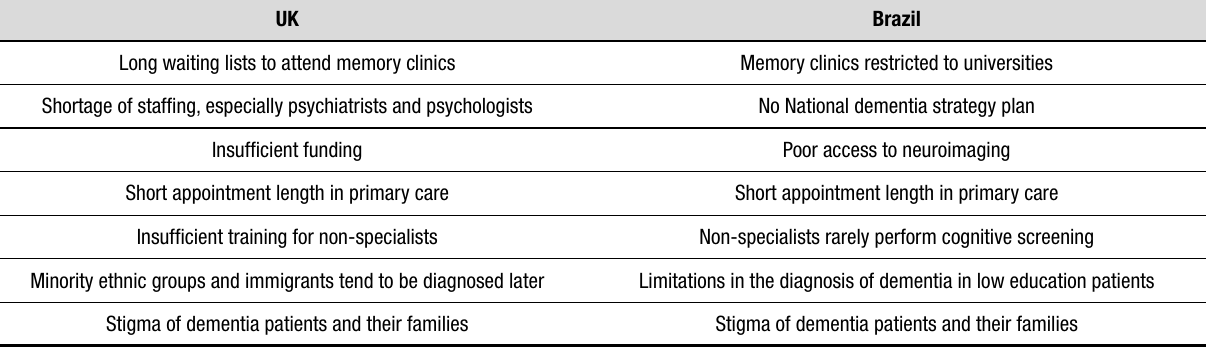
Table 1. Challenges of dementia diagnosis in the United Kingdom (UK) and Brazil. UK Long waiting lists to attend memory clinics Shortage of staffing, especially psychiatrists and